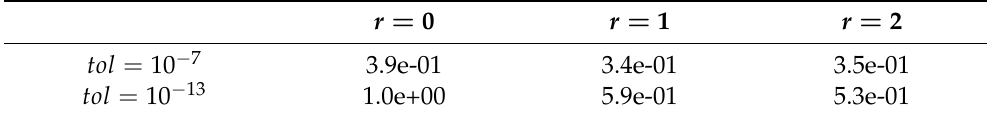
Table 3. CPU time to calculate (6) for the data in Section 2.1 using formula (19) and a modification of subroutine phipm.m (with error estimate (23) and without extrapolation) just for the last